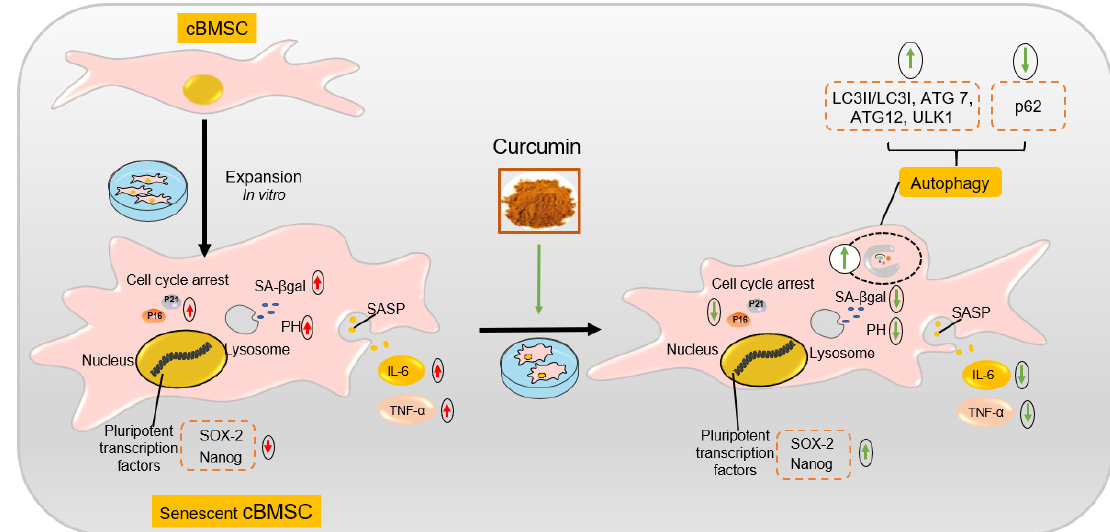
Figure 7. Schematic diagram of the replicative senescence of cBMSCs and the potential mechanisms by which Cur delays cBMSC senescence. cBMSCs (P6) inevitably acquire a senescent phenotype after in vitro expansion, such as a hypertrophic and flat morphology, the activation of cell cycle kinase inhibitors p16 and p21, a decreased expression of pluripotent transcription factors (SOX-2 and Nanog), an enhanced secretion of pro-inflammatory molecules (IL-6 and TNF- α ), and an enhanced activity of SA- β -gal and intraluminal pH in lysosomes. Treatment with curcumin can delay the course of cBMSC senescence, while enhancing autophagic activity and promoting lysosomal acidification. All in all, Cur-induced autophagy is a potential molecular mechanism for ameliorating cBMSC senescence.